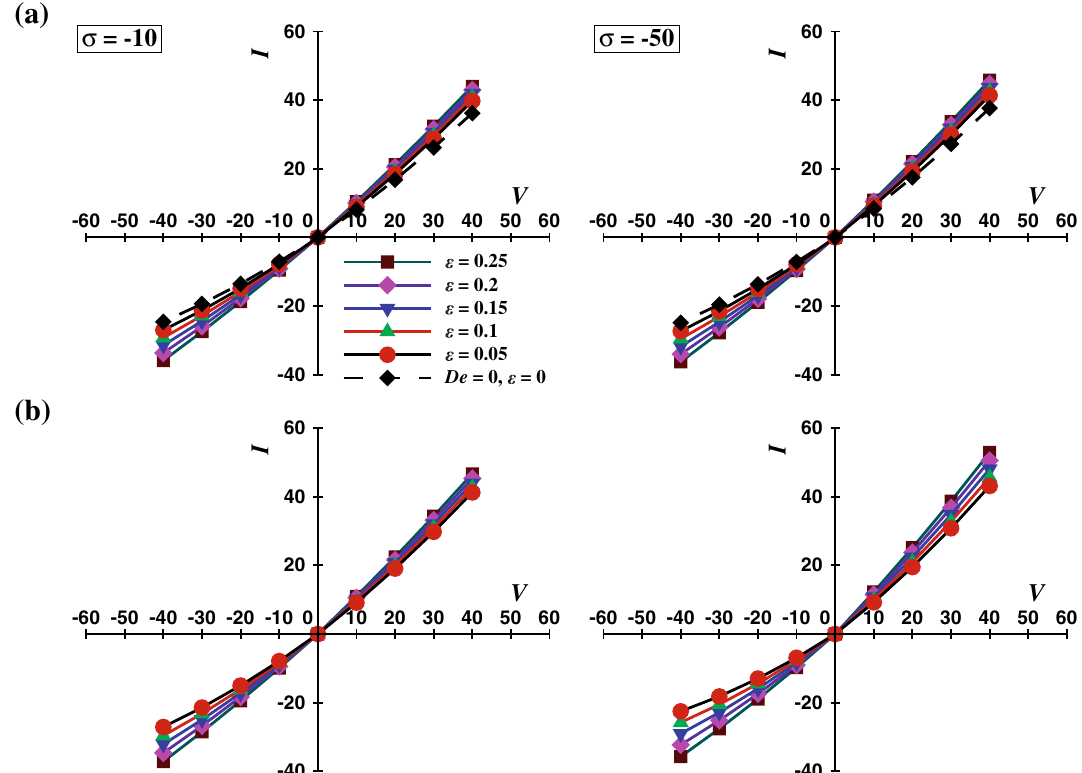
Figure 10. I vs V curve at different values of ε and Newtonian fluid at two extreme values of σ at (a) De = 1 and (b) De = 100 and κ R t = 50 .